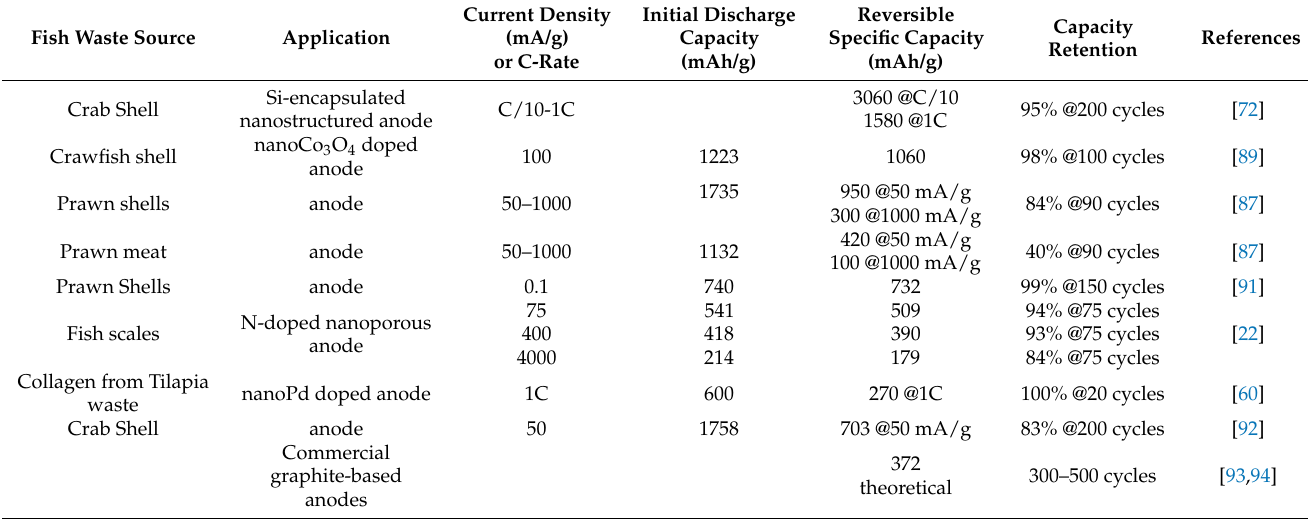
Table 1. Performance of porous carbon-based materials obtained from fish industry waste for Li-ion batteries. Fish Waste Source